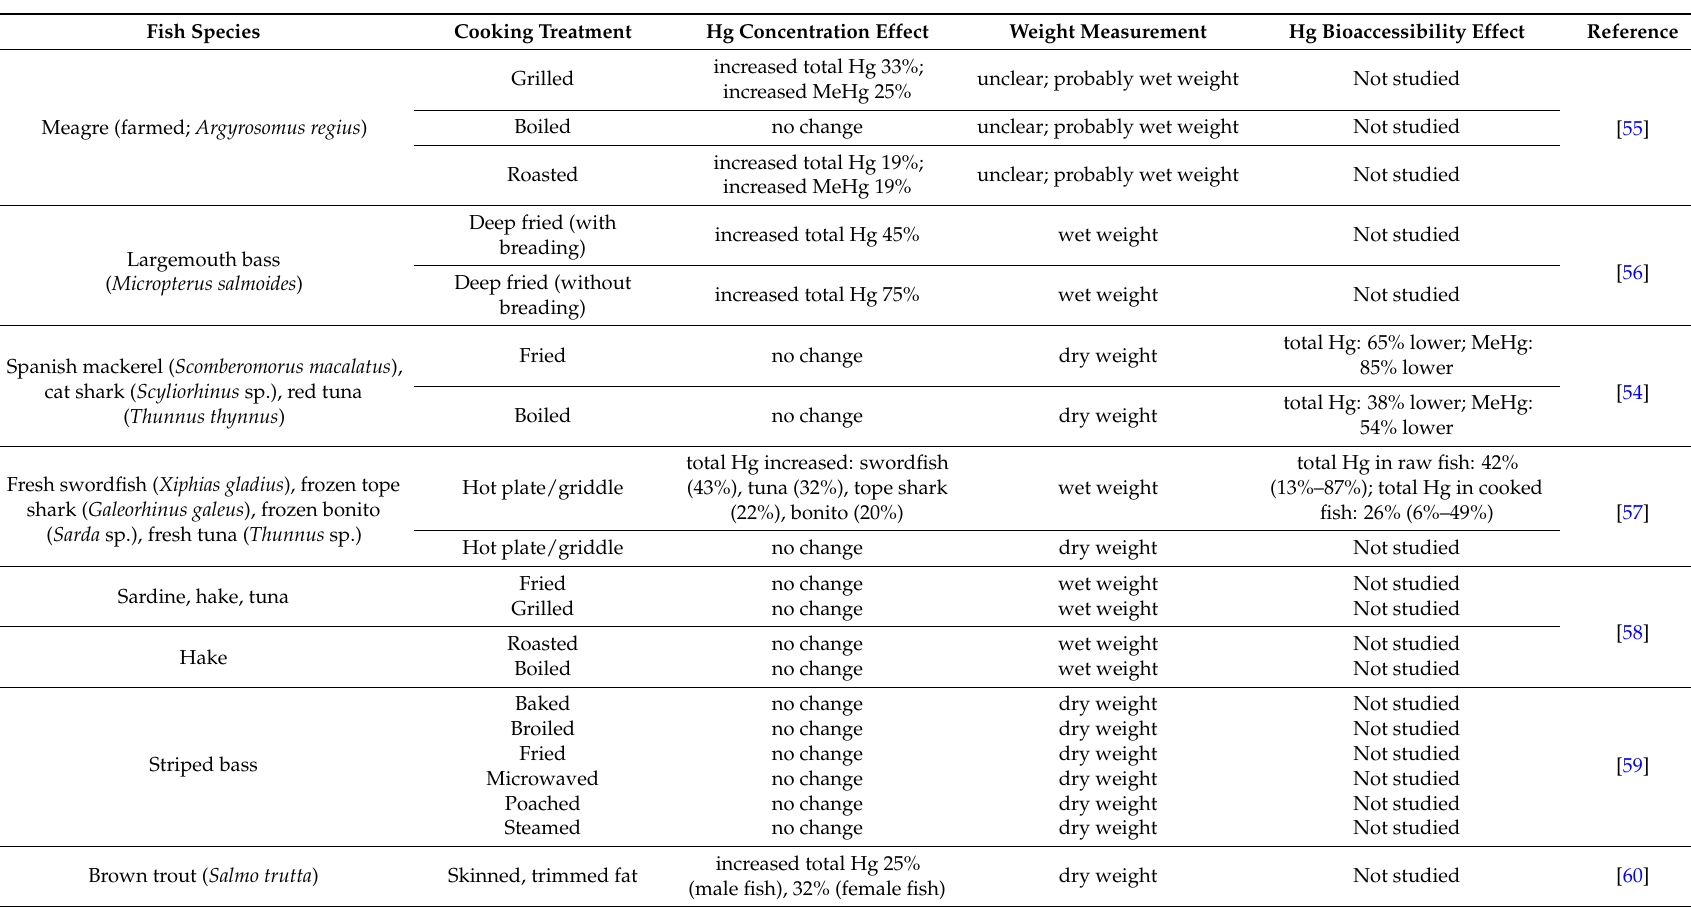
Table 1. Effect of cooking or preparation treatment on Hg concentration, bioaccessibility, and bioavailability. Effects of cooking treatment expressed relative to raw fish; effects of skinning and trimming fat expressed relative to unskinned, untrimmed